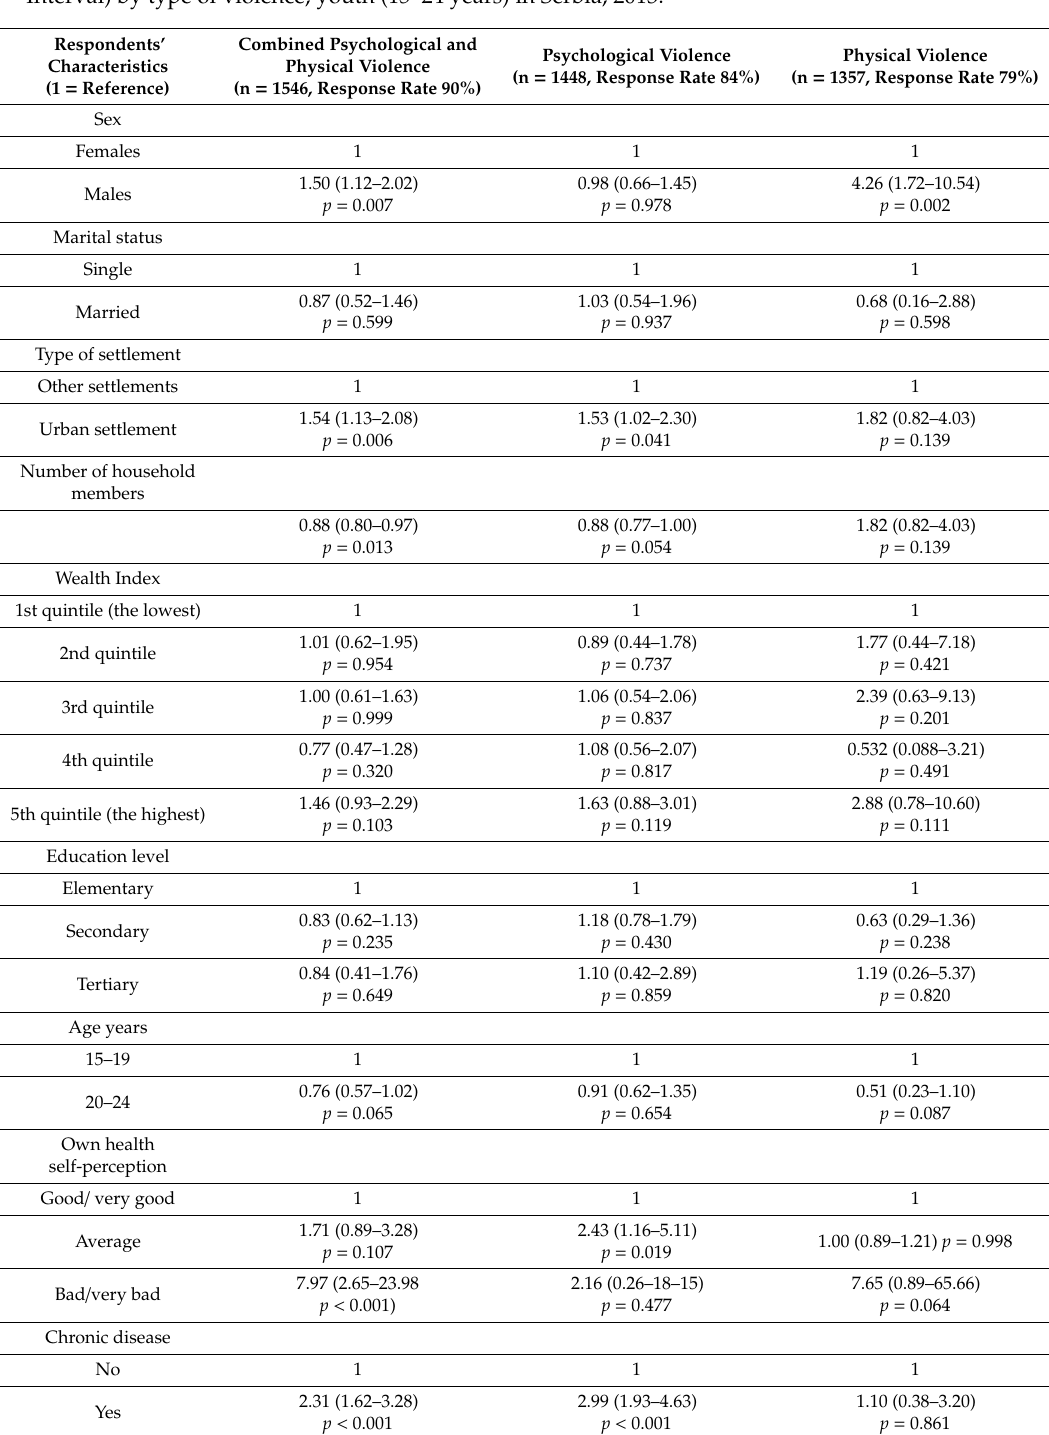
Table 2. Determinants and predictors of violence victimization (Odds Ratios and 95% Confidence Interval) by type of violence, youth (15–24 years) in Serbia,